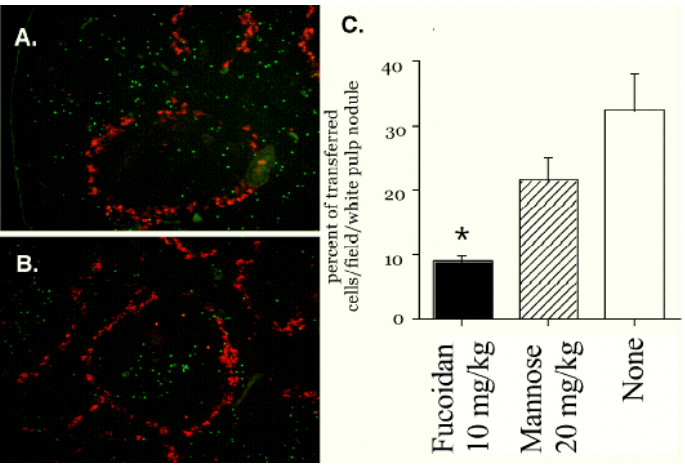
FIGURE 4. Fucoidan inhibits T lymphocyte accumulation in the white pulp of the spleen. 10 7 purified C57BL6/J CFSE-labeled T lymphocytes were injected into syngeneic recipients together with either 10 mg/kg fucoidan (panel A) or 20 mg/kg mannose (panel B). Spleens were harvested 90 min after transfer and stained as in Fig. 1. Panel C shows that the only significant difference between untreated, fucoidan-treated, and mannose-treated lymphocytes was that the fucoidantreated T lymphocytes accumulated less in the white pulp than untreated cells. Mannose had no significant effect on cell accumulation. The number of transferred cells within the white pulp was calculated as in Fig. 3. Data are presented as means ± SEM; n > 3 mice per timepoint. * p < 0.05 vs. lymphocytes transferred without fucoidan or